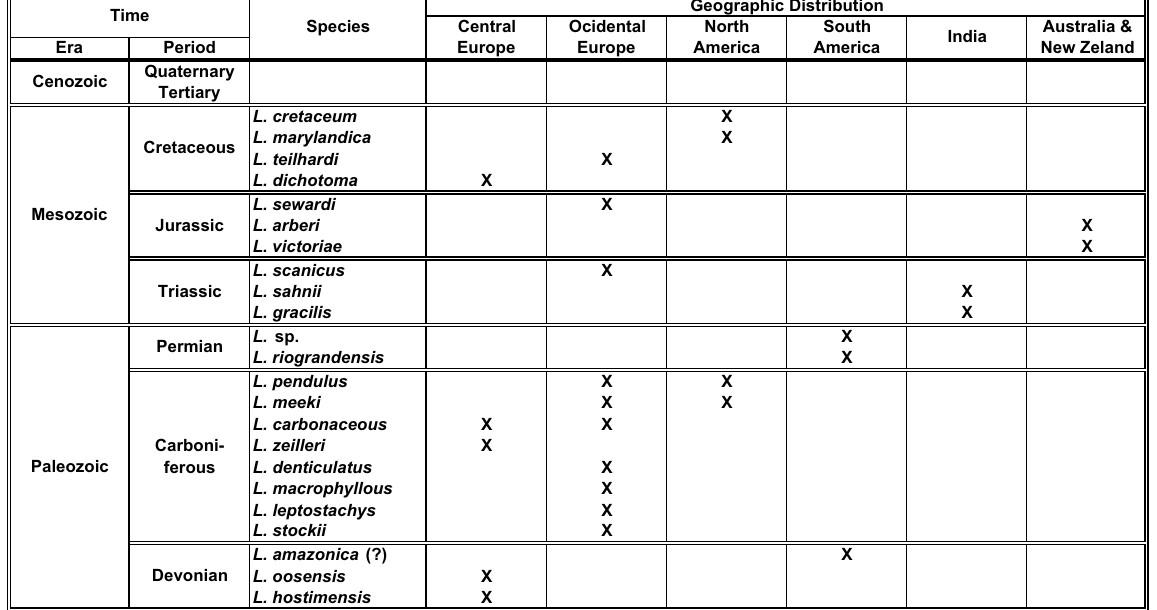
Fig. 4 – Distribution of the genus Lycopodites during the